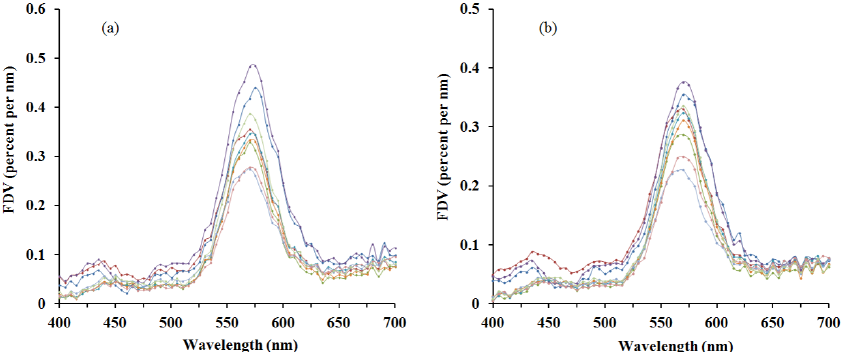
Figure 2. First derivative curves of pilot samples before (a) and after 200 ◦ C heating (b) . After 200 ◦ C heating, the presence of first derivative peaks are similar to those before heating. All curves show a significant peak at ∼ 575nm, indicating the existence of